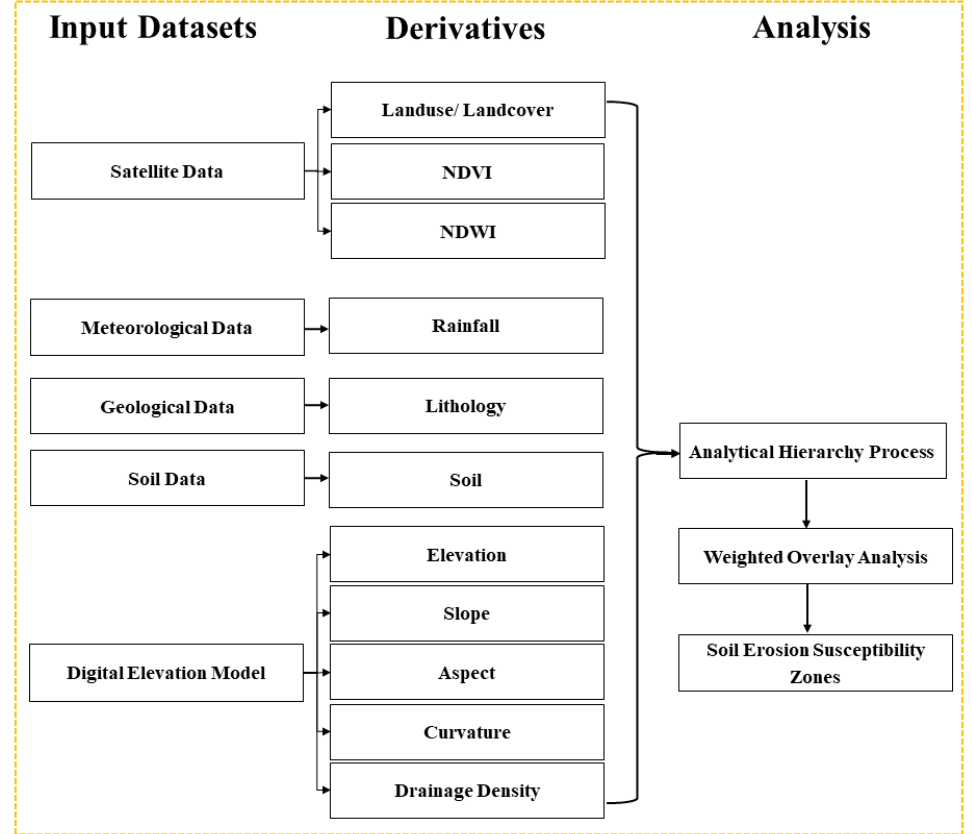
Figure 2. Flowchart of the methodology adopted